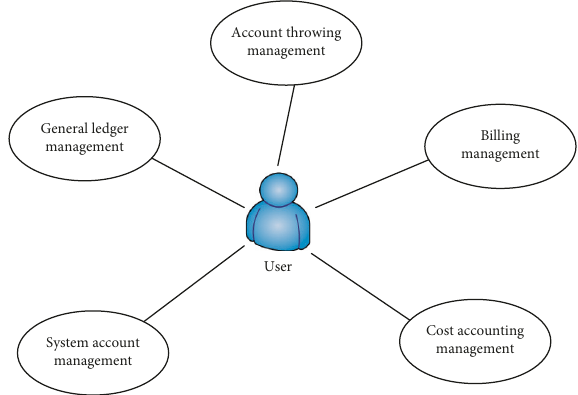
Figure 4: Business use case diagram of financial management costing